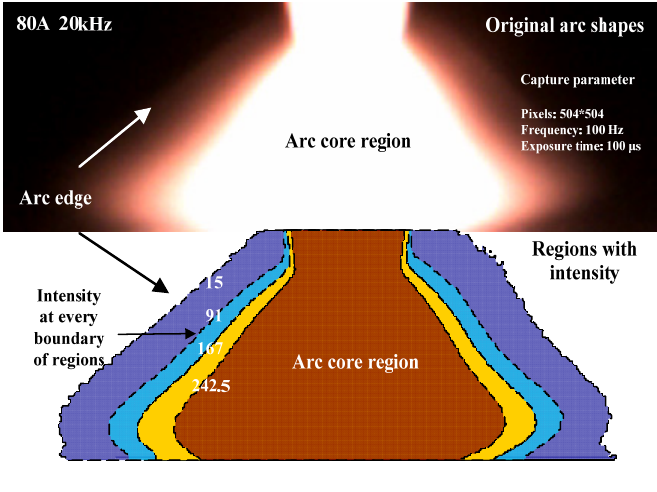
Figure 3. Arc regionalization.